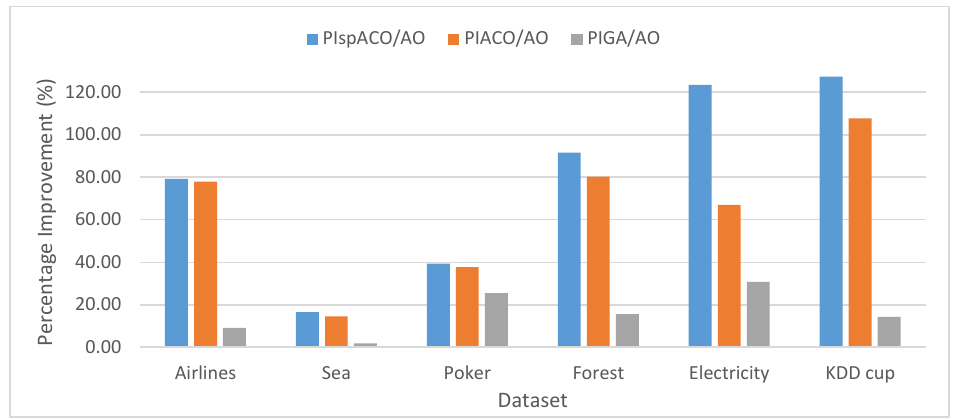
Figure 3. Analysis of PI for PCAES in different algorithms over IT2FCM-AO.